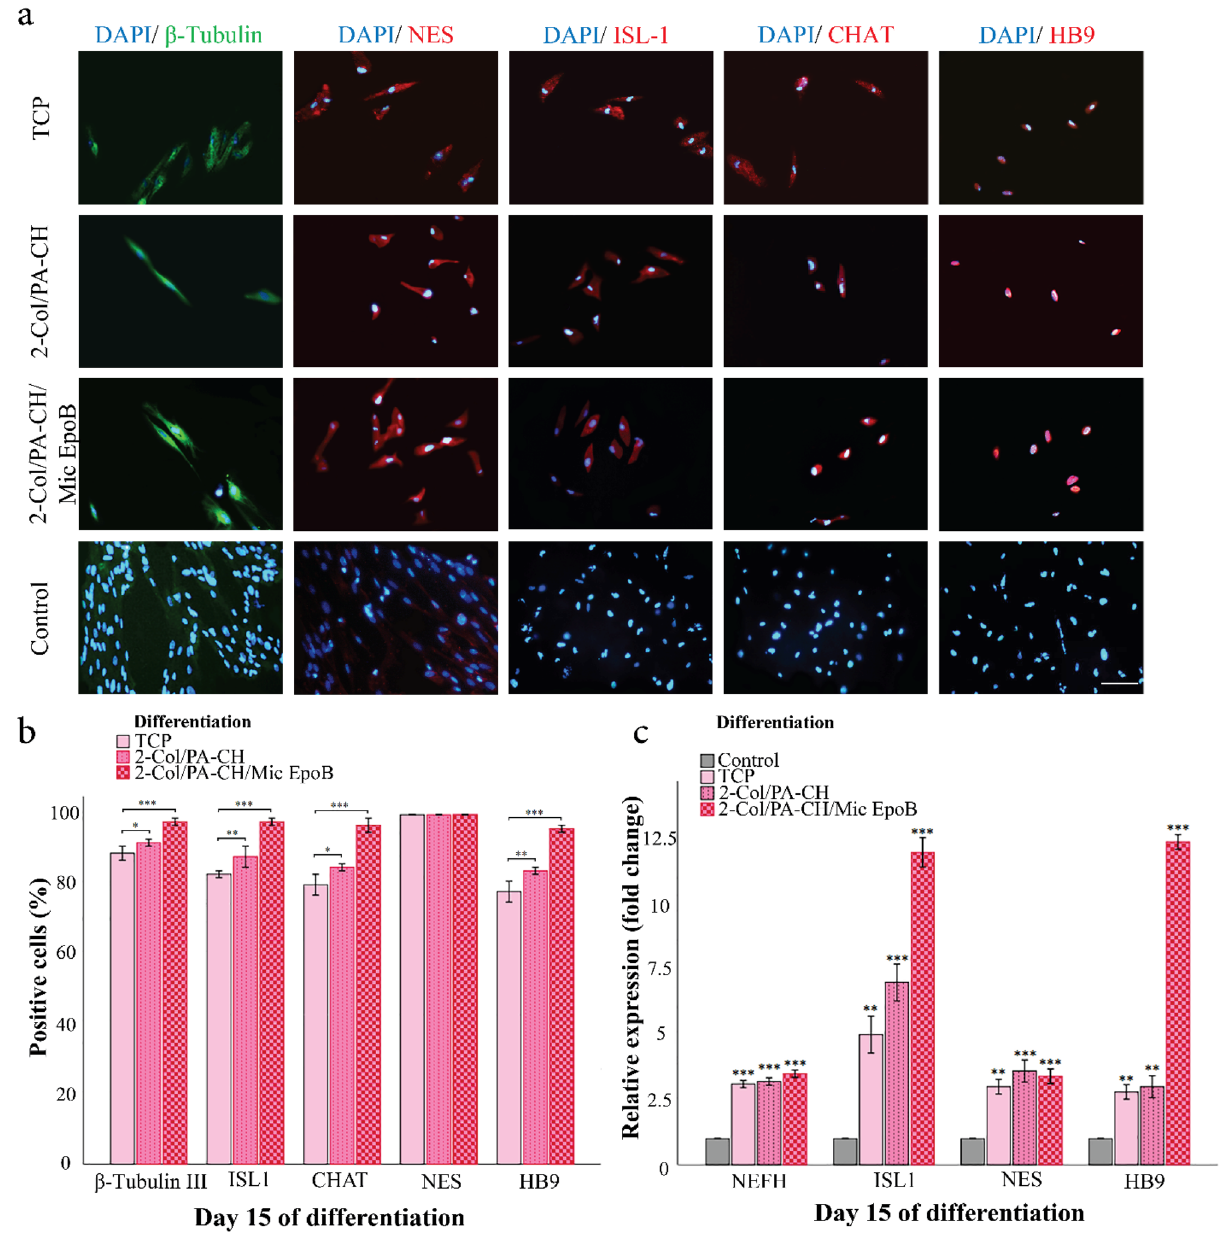
Figure 8. The expression of MN-like cells differentiated from hEnSCs in different groups. ( a ) Immunofluorescence images of MN-like differentiated hEnSCs in different groups of TCP, collagen hydrogel without Mic EpoB (2-Col/PA-CH/M), collagen hydrogel with Mic EpoB (2-Col/PA-CH/Mic EpoB), and control (undifferentiated hEnSCs) for beta-III-tubulin, NES, ISL-1, CHAT, and HB9 after 15 days (× 20, Scale bar 100 μm). ( b ) Expression (ratio of positive cells, %) of MN markers calculated from three wells (five fields per well). ( c ) Relative gene expression in three differentiated groups, including TCP, Col without Mic EpoB, Col with Mic EpoB, and control (undifferentiated hEnSCs) after 15 days for NEFH, ISL-1, NES, and HB9. Graphs were generated with SPSS 21 (simple bar, summaries for groups of cases). Data were presented as three independent experiments. (Error bars: ± 1 SD). The p-values were assessed using SPSS 21, one-way ANOVA, and the DUNNETT test. In part B: Col without Mic EpoB and Col with Mic EpoB groups were compared with TCP: *P < 0.05, **P < 0.01, ***P < 0.001. In part C: The effects of three differentiation groups (TCP, col-without Mic EpoB, and col-with Mic EpoB) compared with control group (undifferentiated hEnSCs): *P < 0.05, **P < 0.01, ***P <